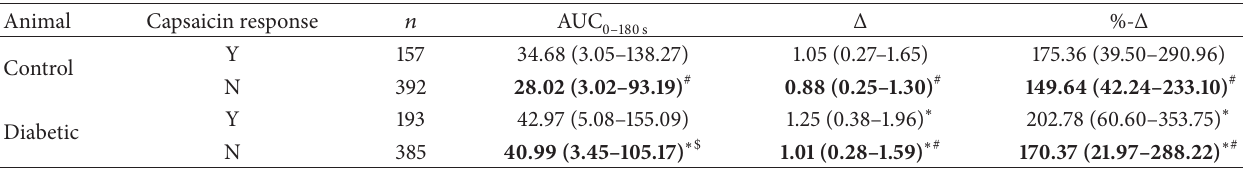
AUC: Area under the curve for 0–180s, Δ : the absolute change in [Ca 2+ ] 𝑖 (fluorescence ratio), % - Δ : the change in [Ca 2+ ] 𝑖 (fluorescence ratio) measured in % change from baseline. Y: Yes and N: No. ∗ 𝑃 < 0.001 versus corresponding control neurons, # P < 0.001 and $ P < 0.05 versus corresponding capsaicin-responsive neurons.